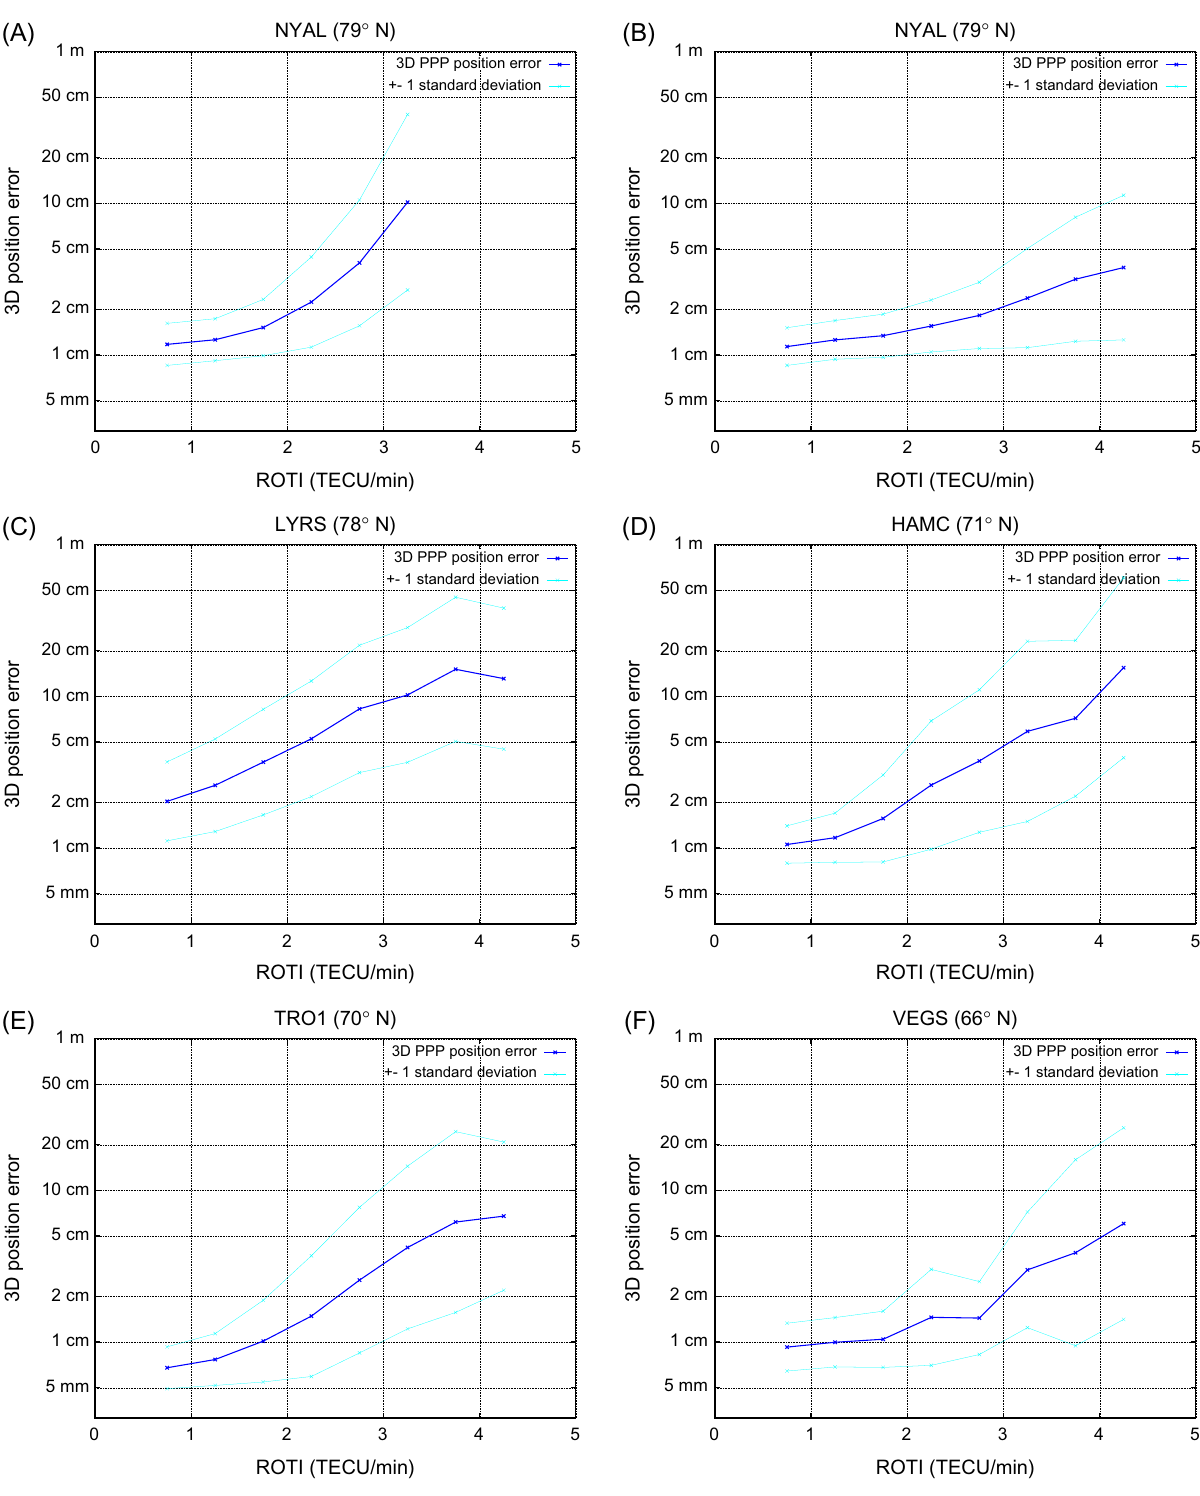
Fig. 3. Statistical relationship between mean ROTI and 3D position error, for these receivers: (A) NYAL, (B) NYA1, (C) LYRS, (D) HAMC, (E) TRO1, (F)